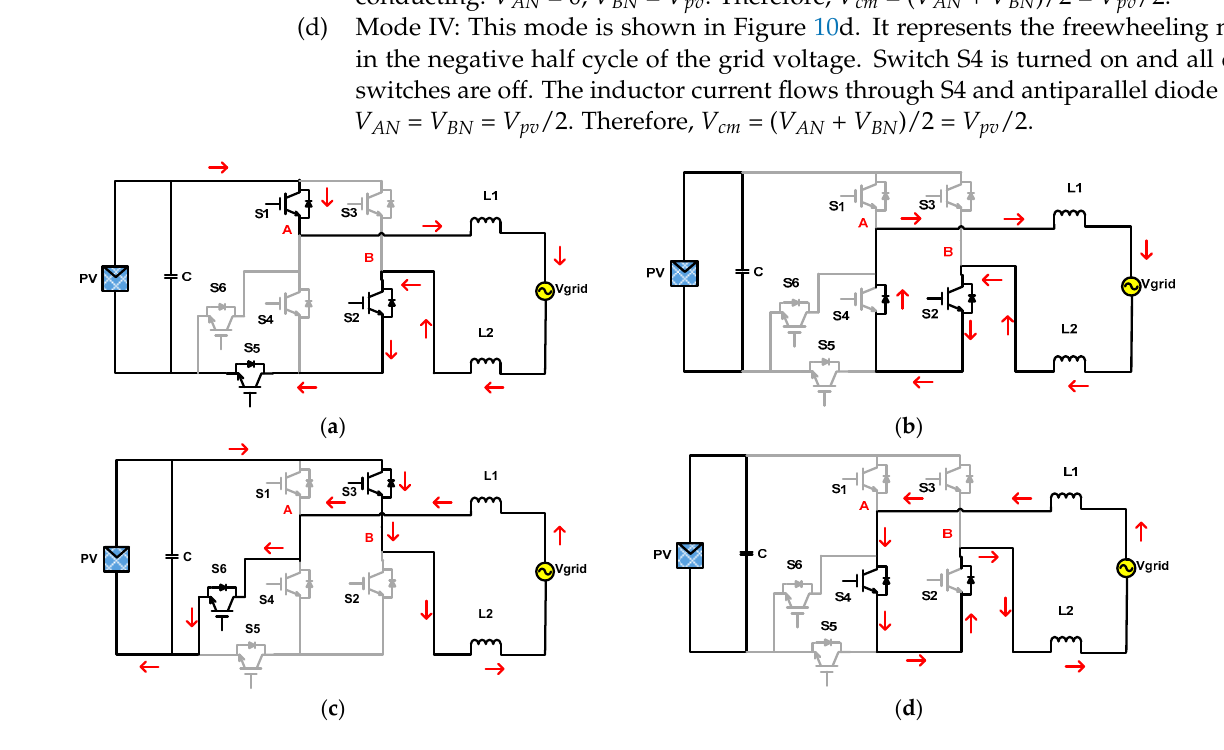
Figure 10. Proposed novel H6 inverter operating modes. ( a ) Current conduction during the positive half cycle of the grid voltage, ( b ) freewheeling mode during the positive half cycle of the grid voltage, ( c ) current conduction during the negative half cycle of the grid voltage and ( d ) freewheeling mode during the negative half cycle of the grid voltage.